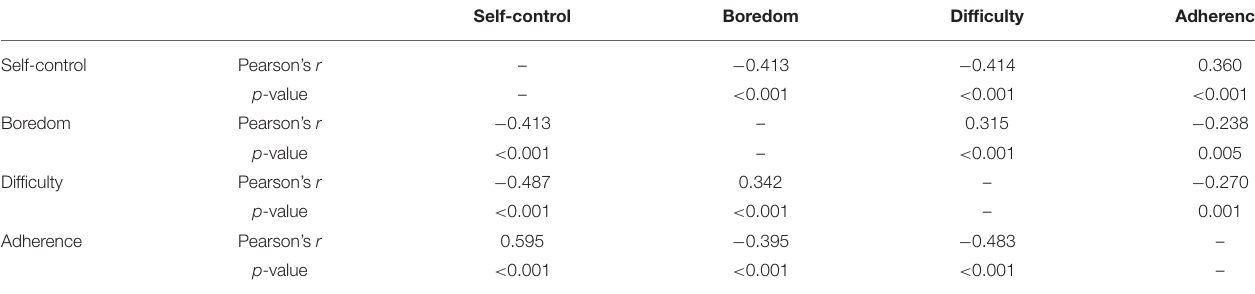
TABLE 2 | Correlations of measures. Self-control Boredom Difficulty Adherence